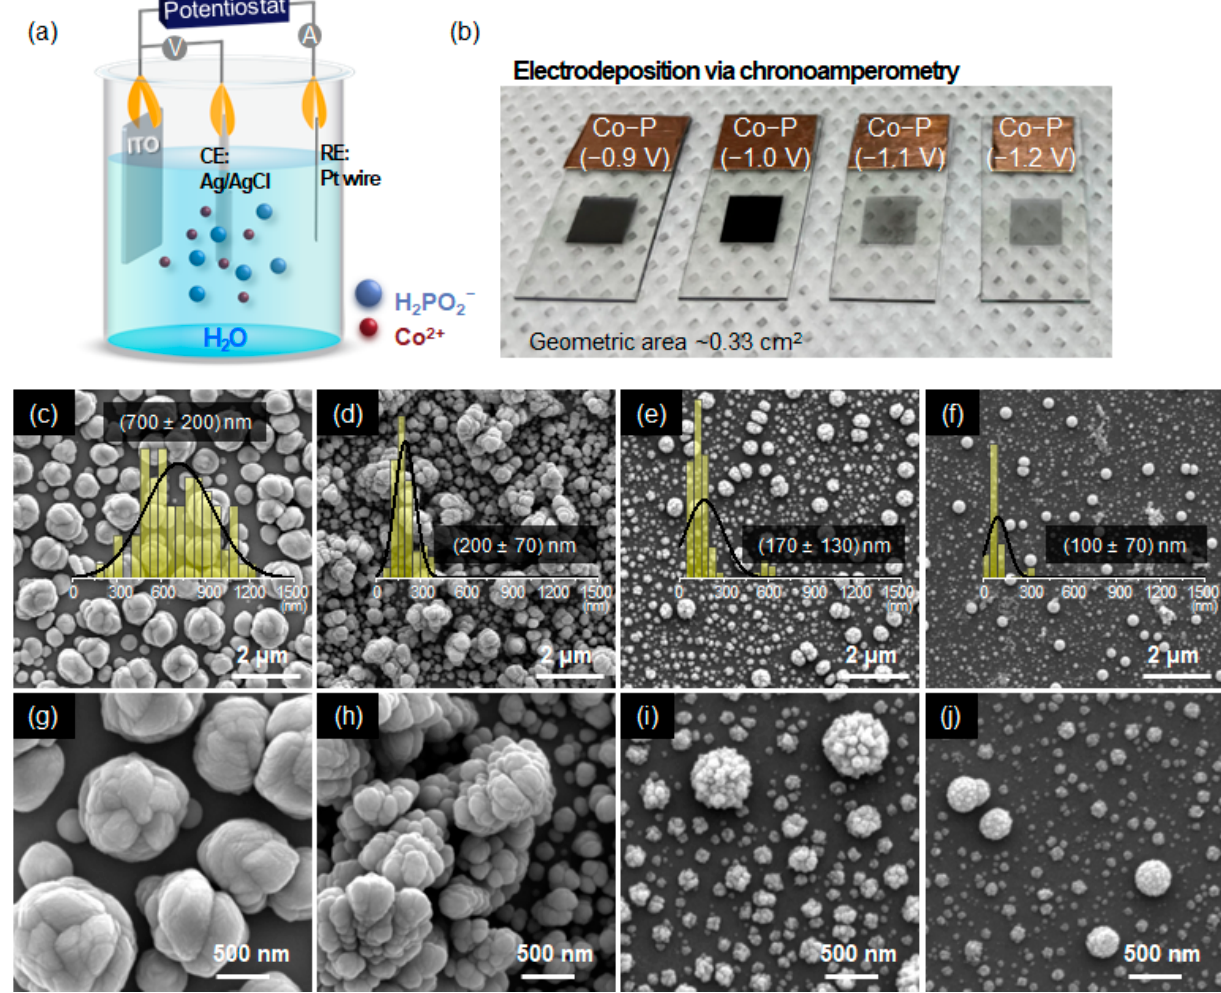
Figure 1. ( a ) Schematic of the Co-P nanocluster generation by electrodeposition. ( b ) Photographs and ( c – j ) SEM images of the resulting Co-P nanostructures on ITO which were grown at various applied potentials: ( c , g ) − 0.9 V, ( d , h ) − 1.0 V, ( e , i ) − 1.1 V, and ( f , j ) − 1.2 V (inset: size distribution histogram of nanoclusters).